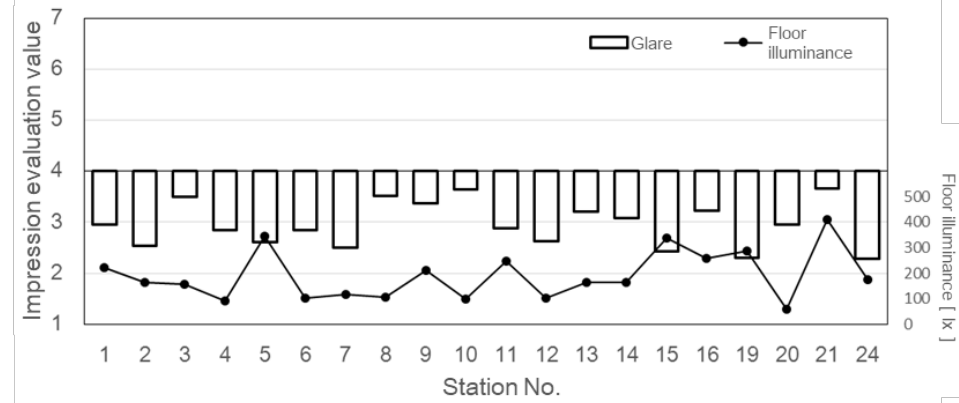
Figure 15. Results of impression evaluation of glare and floor illuminance.